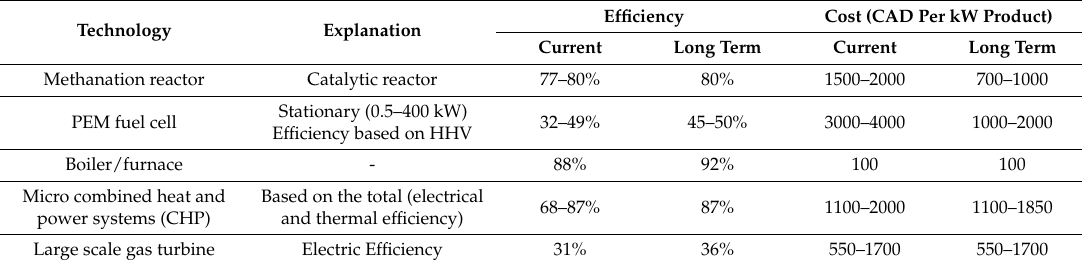
Table 4. Economics and efficiency of different technologies